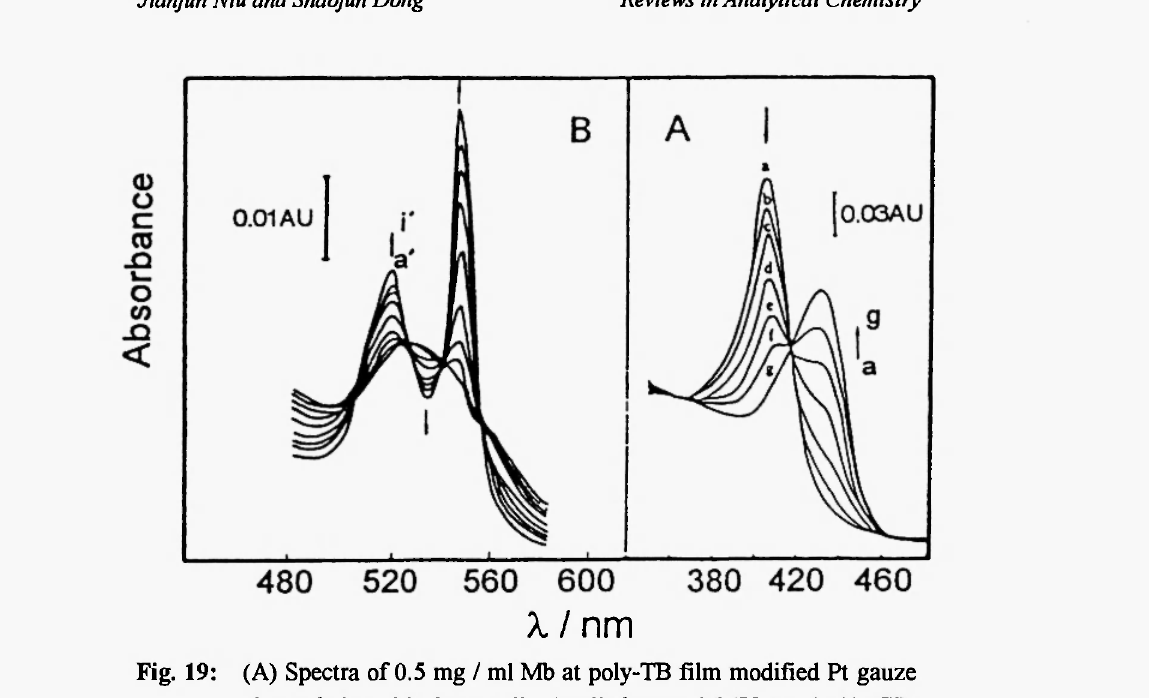
Fig. 19: (A) Spectra of 0.5 mg / ml Mb at poly-TB film modified Pt gauze electrode in a thin-layer cell. Applied potential (V, vs. Ag/AgCl): a, +0.40; b, -0.10; c, -0.12; d, -0.14; e, -0.16; f, -0.18 and g, -0.30. Solution: 0.2 Μ KN0 + 0.05 Μ phosphate buffer with 3 pH 7.0. (B) Spectra of 1 mg/ml Cyt c at several applied potentials: a', +0.20; b\ +0.12; c\ +0.10; d' +0.08; +0.06; ; f, +0.04; g', +0.02; h', 0.0 and i', -0.20. (From Refs. 202 and 199,